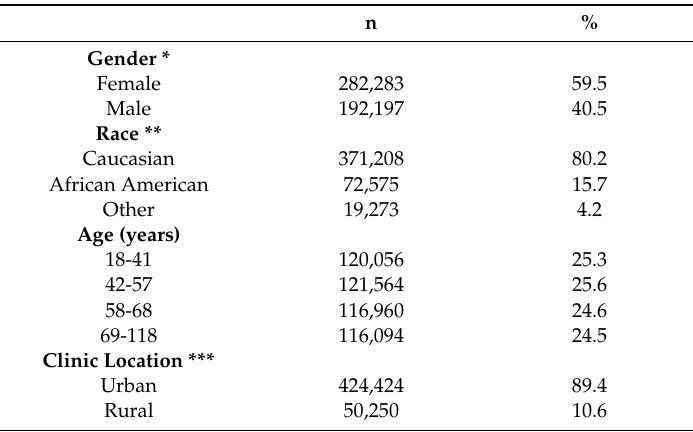
Table 1. Sample demographics (n =